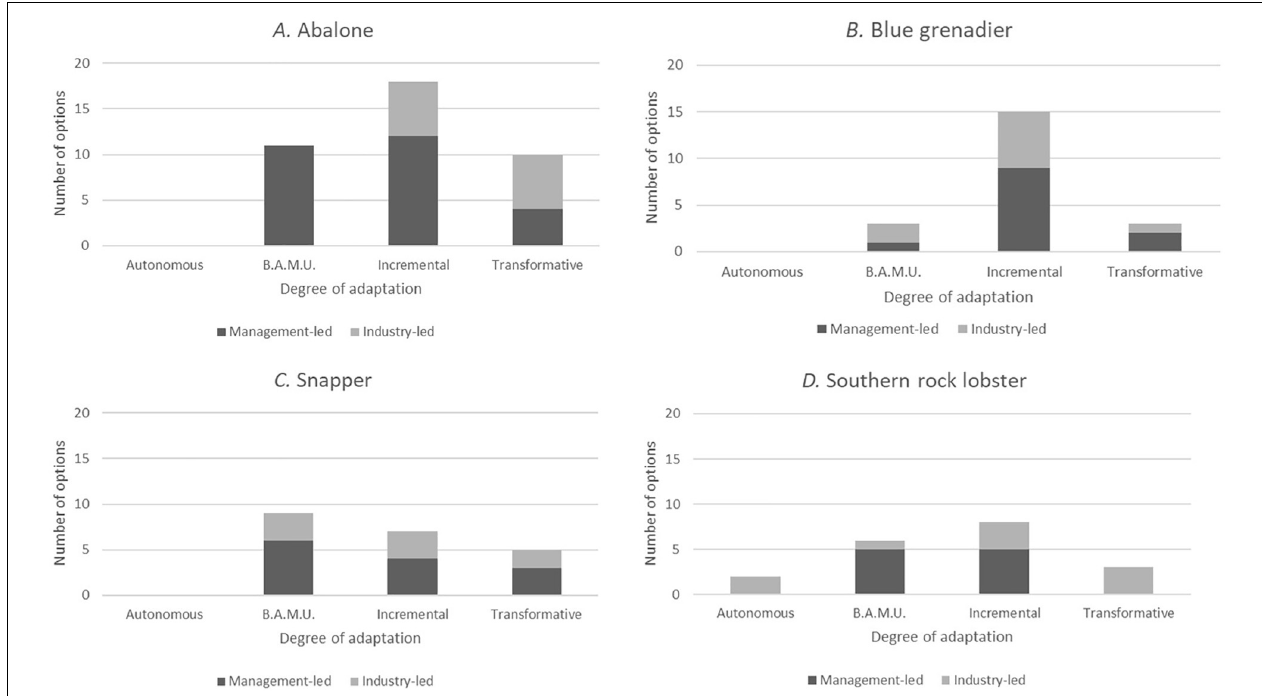
FIGURE 2 | Comparison of number of adaptation options for abalone (A) , blue grenadier (B) , snapper (C), and southern rock lobster (D) fisheries in south-eastern Australia by their summary characteristics: degree of adaptation and primary implementation